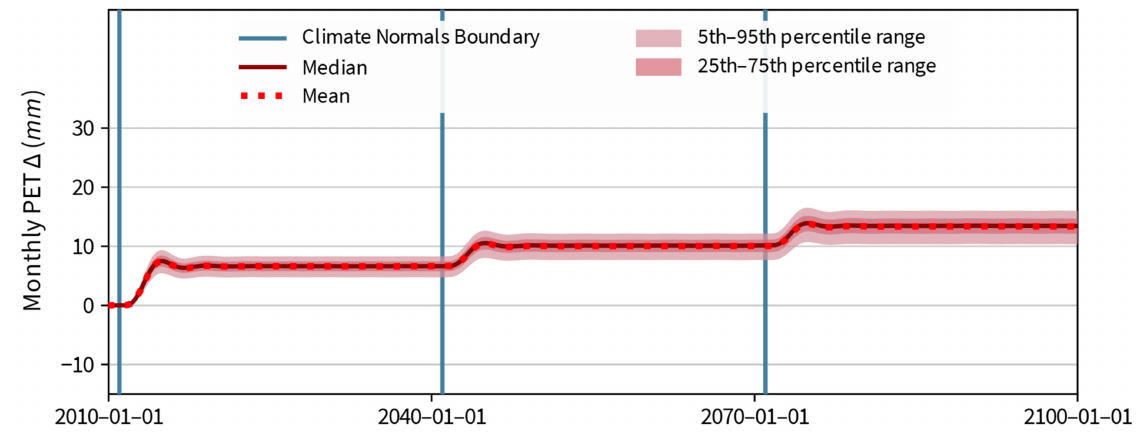
Figure 7. Probabilistic description of projected future changes in PET. These results are from the CC scenario in Table 1 where the framework is used to compare future climate trends to historical conditions. Adapted from Martin [19] CC BY